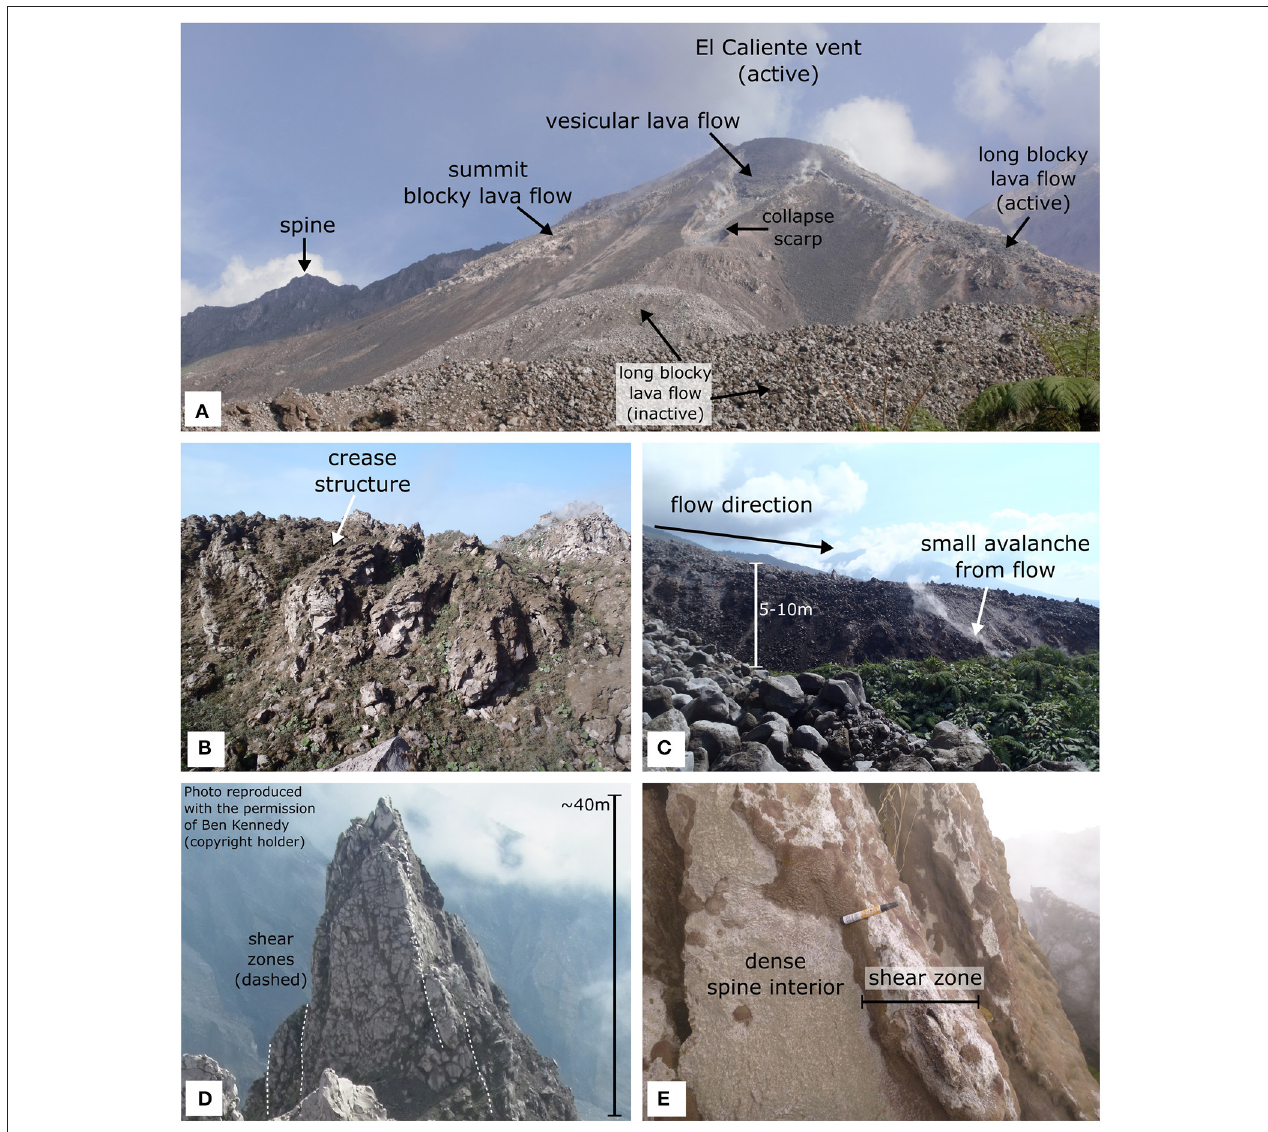
FIGURE 3 | Photos of lava types. (A) El Caliente from the south, November 2012, where a vesicular lava is infilling a recent collapse scarp, and long blocky lava flow and summit blocky lava flow are also active. Spines from El Monje can be seen in the distance. (B) A vesicular lava flow on El Brujo, this flow is semi-circle shaped and exhibits a crevasse with features similar to crease structures described at Mount St. Helens by Anderson and Fink (1992). (C) A long blocky lava flow ∼ 1km from the vent. (D) A prominent spine on La Mitad. (E) Close up of a spine showing the dense spine interior and shear zone